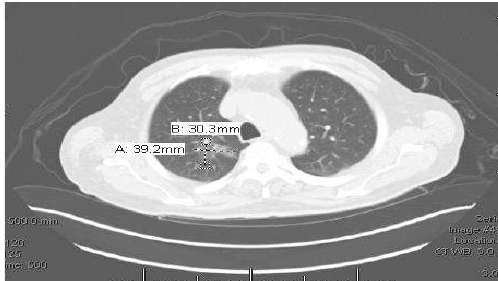
Figure 3: CT scan showing a 3.9 × 3 cm mass in upper lobe of right lung.